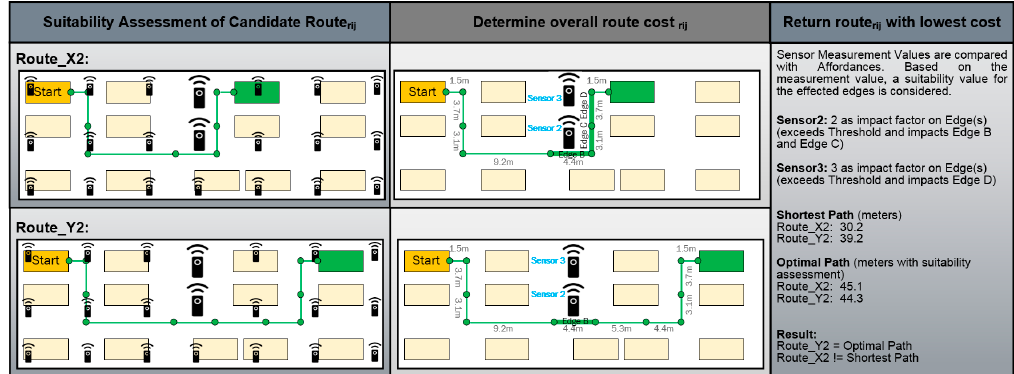
Figure 7. Case study: Route determination based on the ad-hoc suitability network where the optimal path does not equal the shortest path.